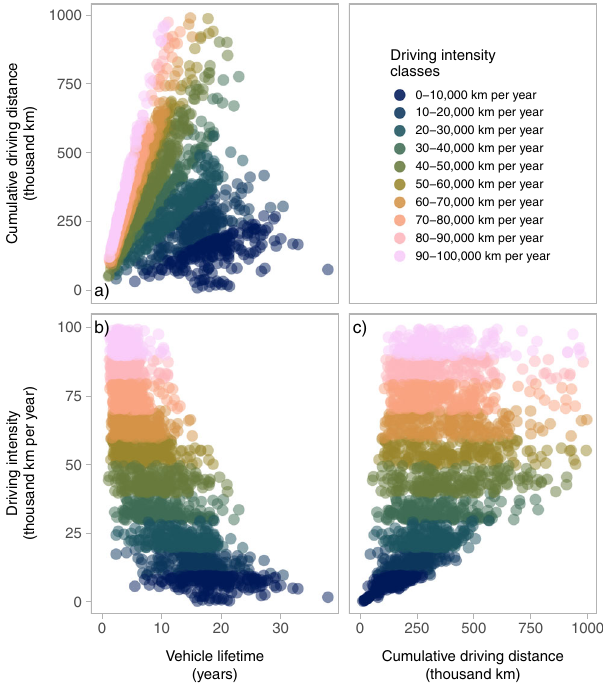
Fig. 1 | Statistical analysis of vehicle retirements. a Vehicle lifetime and cumu- lative driving distance. b Vehicle lifetime and average driving intensity. c Cumulative driving distance and average driving intensity. Results are shown for strati fi ed samples based on average annual driving intensity classes of Swedish ICEVsretiredbetween2014and2018.Thecolorindicatesthedrivingintensityclass of the data